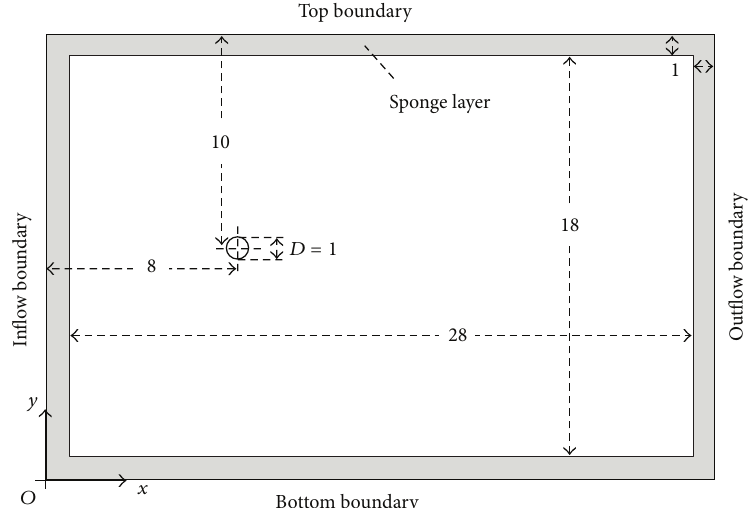
Figure 6: Schematic of the computational domain.